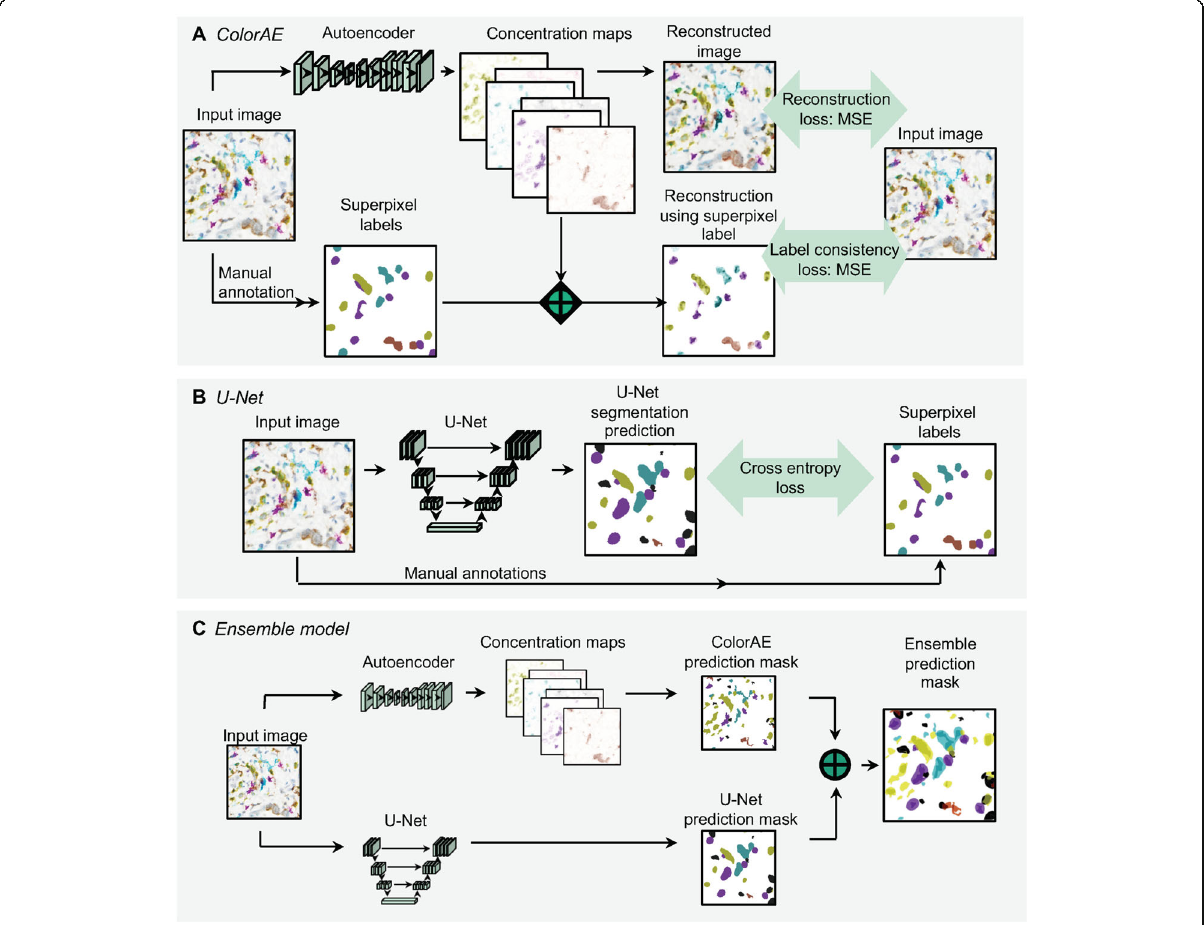
Fig. 3 Algorithm training. a ColorAE training. Input image is run through an autoencoder to yield concentration maps of each color (6 distinct mIHC stain colors: yellow, teal, purple, red, black, brown; blue hematoxylin nuclear counterstain; and background.) Two loss functions are applied to ensure that the reconstructed image has the highest fidelity to the original image and expert weak annotations. b U-Net training . Input image was run through a U-Net. Cross entropy loss function was applied to maximize fidelity to superpixel labels derived from manual annotation of the input image. c Ensemble method workflow . Input image is run through the autoencoder and U-Net to generate predictions as shown